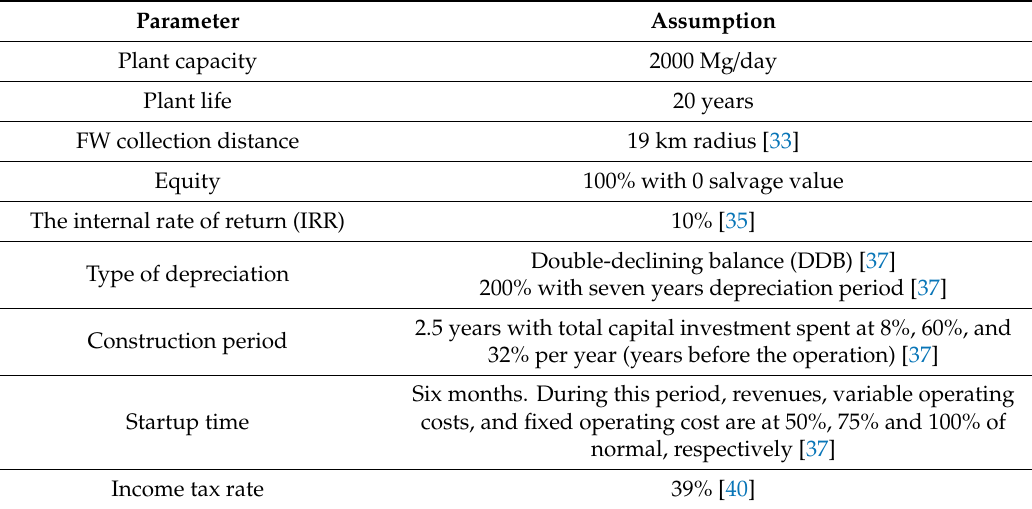
Table 1. Financial economic assumptions used for the techno-economic analysis.